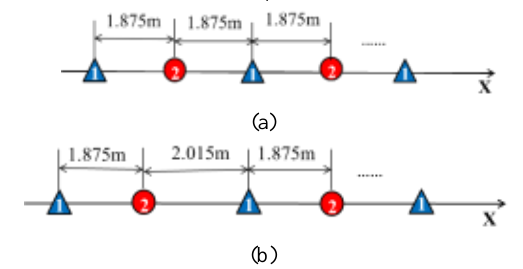
Figure 4. Illustration of spatial sampling: (a) uniform sampling, and (b) practical